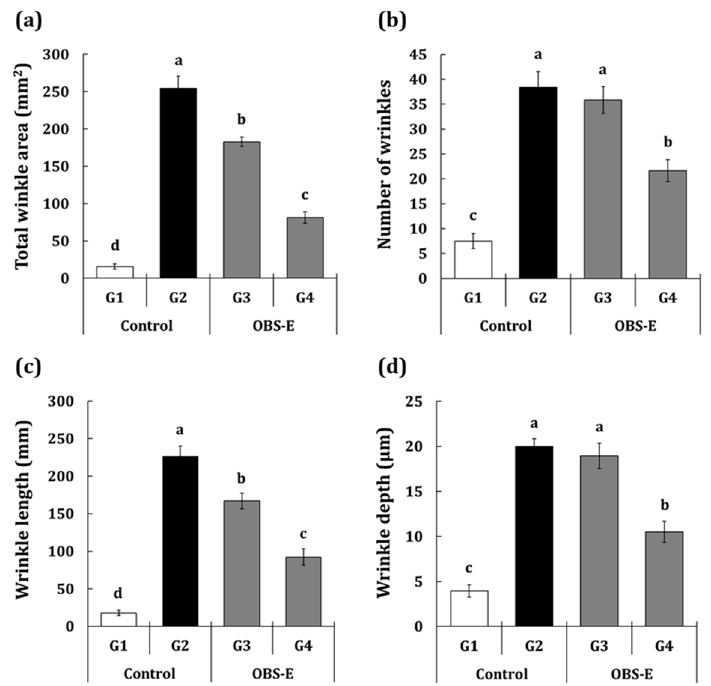
Figure 2. Effect of oral administration of OBS-E on wrinkle formation. ( a ) total wrinkle area, ( b ) wrinkle number, ( c ) wrinkle length, and ( d ) wrinkle depth. G1, non-irradiated control group ad- ministered saline; G2, UVB-irradiated control group administered saline; G3 and G4, UVB-irradiated test agent groups administered OBS-E at doses of 50 and 200 mg/kg BW/day, respectively. Different superscripts indicate significant difference among groups by Duncan’s multiple range test ( p < 0.05).